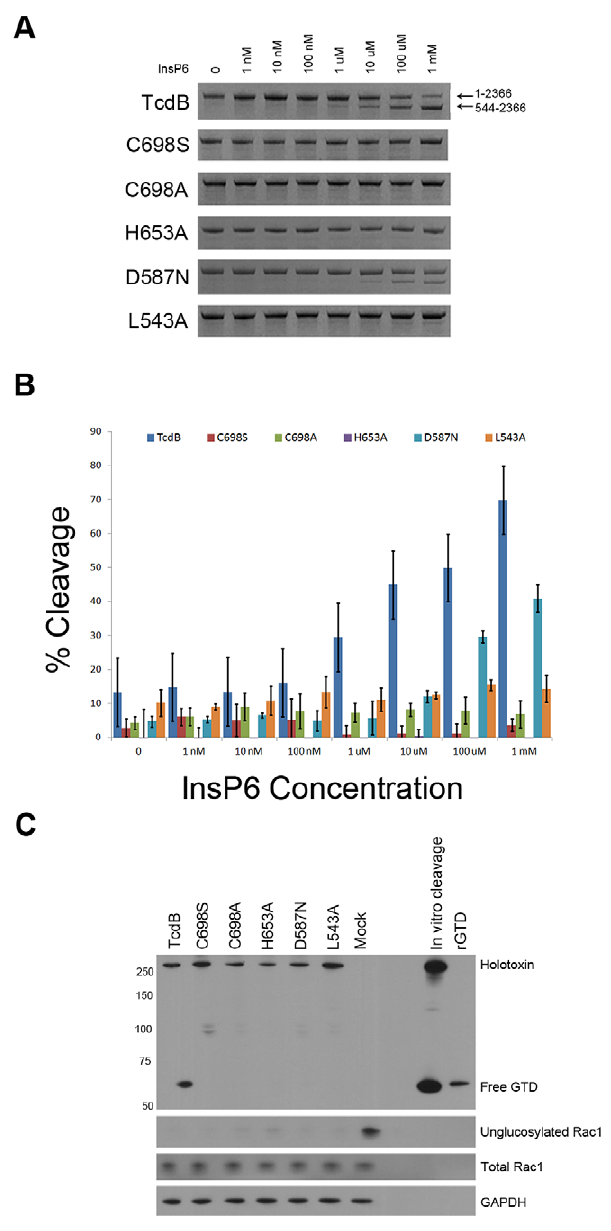
Figure 2. Mutations in the autoprocessing domain active site and the cleavage site result in TcdB proteins with impaired autoprocessing activity invitro and in cells. A , Autoprocessing was induced in vitro by incubating wild-type TcdB and TcdB mutants with multiple InsP6 concentrations and 1 mM DTT at 37 u C. After 2 hours, the proteins were subjected to SDS-PAGE and visualized with Coomassie stain. A representative series of gels is shown from experiments performed in triplicate. B , Three replicates of the experiments shown in panel A were quantified by densitometry. Bands corresponding to TcdB 544–2366 were quantified and normalized to the band corresponding to TcdB 1–2366 without InsP6. Error bars reflect the standard deviation of the percent cleavage between three experiments. The data indicate that wild-type TcdB autoproteolysis can be detected at concentrations of 1 uM to 1 mM InsP6. By comparison, TcdB mutants C698S, C698A, and H653A were completely inactive for autoprocessing at all InsP6 concentrations. The TcdB D587N and L543A had some residual activity, but autoprocessing activity was impaired relative to wild-type. C , GTDs of autoprocessing mutants are not released in cells. HeLa cells were synchronized for 30 minutes at 4 u C, then intoxicated with 10 nM